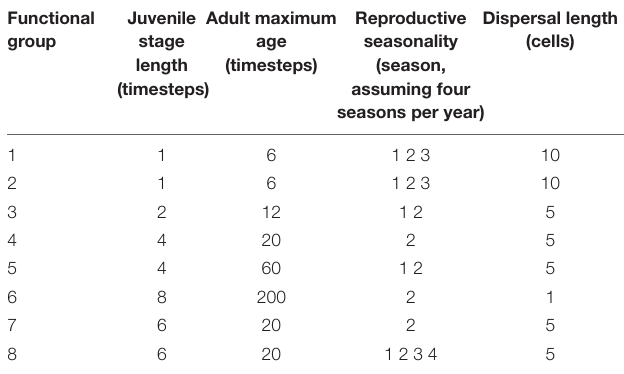
TABLE 2 | Age limit, reproduction, and dispersal length scale rules for all functional groups. Functional